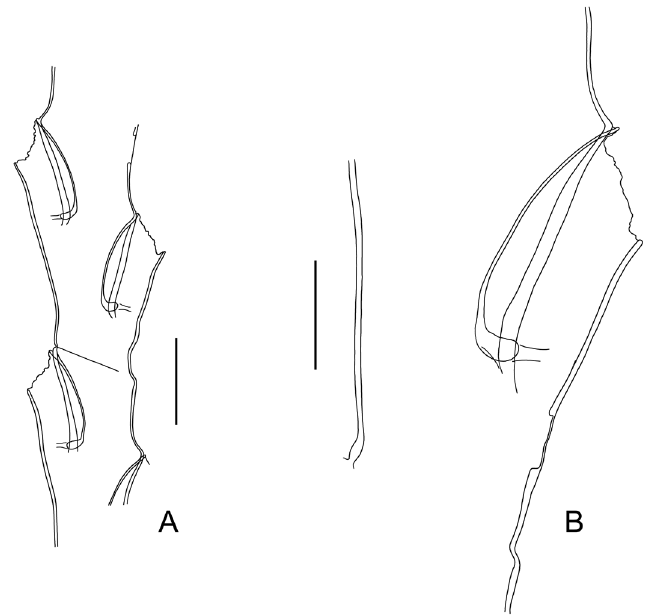
Fig. 4. Tasmanaria edentula (Bale, 1924). A–B . Portion of branch (A), hydrotheca (B), both from